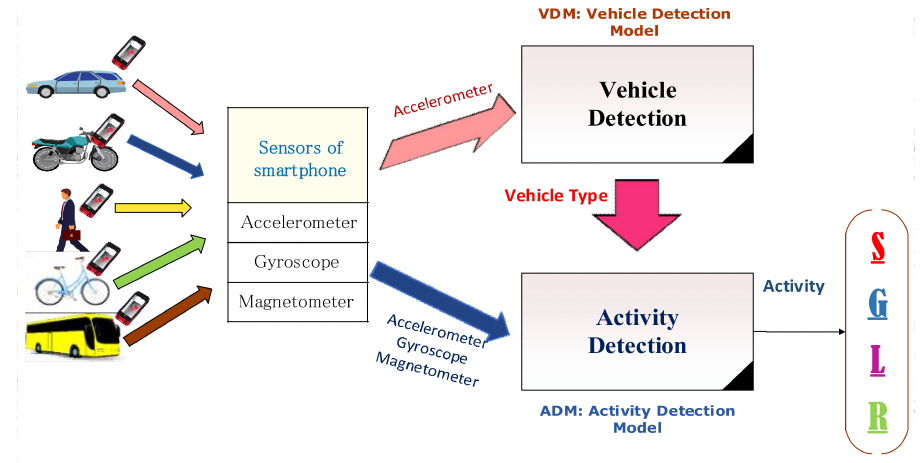
Figure 1. The Vehicle mode-driving Activities Detection System